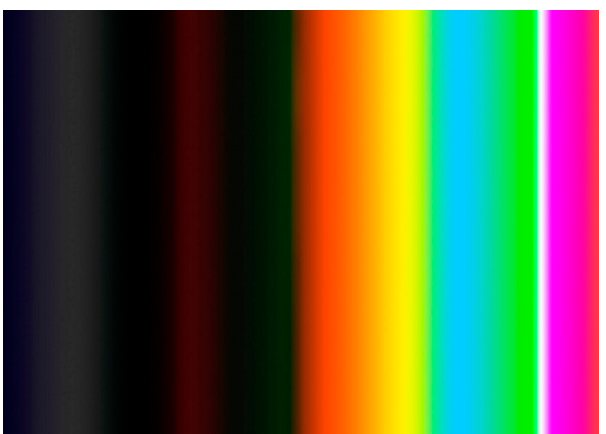
Figure 4. The color scale, including light color set and dark color set, that was displayed for 3 s after each emotional stimulus. Source: researcher’s own design.